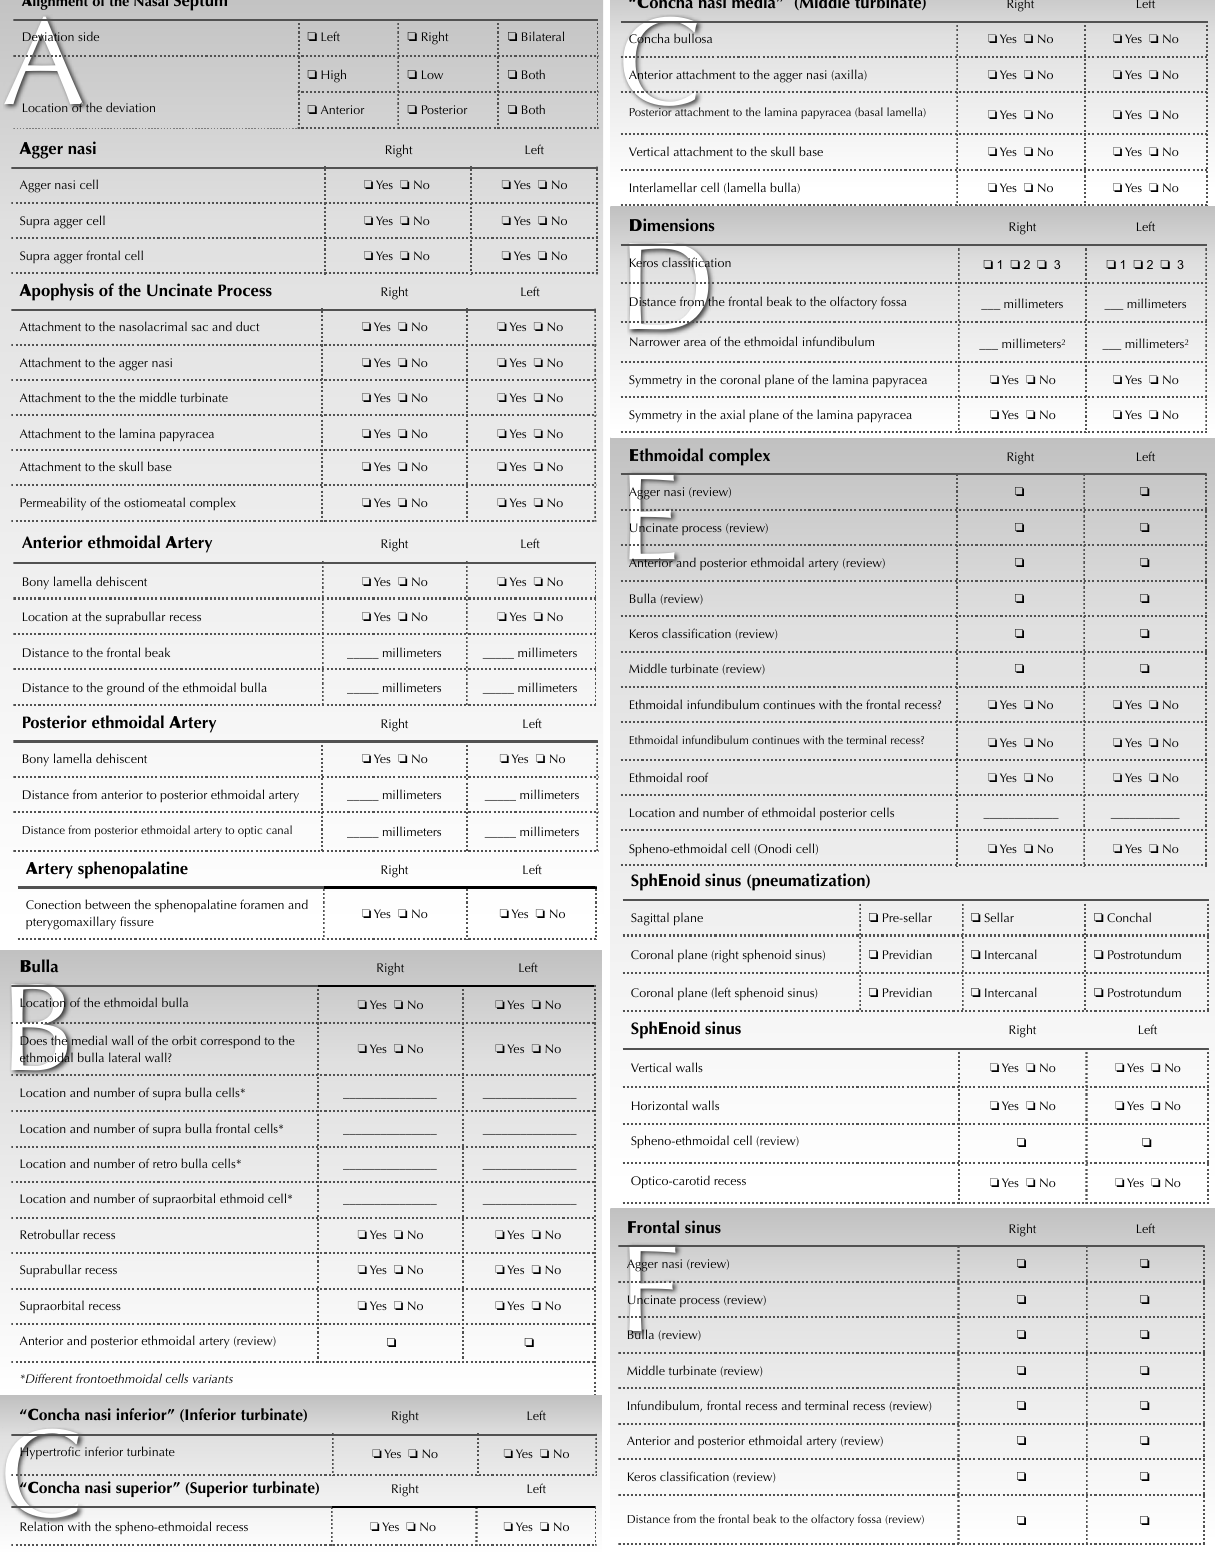
Figure 1. "ABCDEF checklist" for preoperative planning of